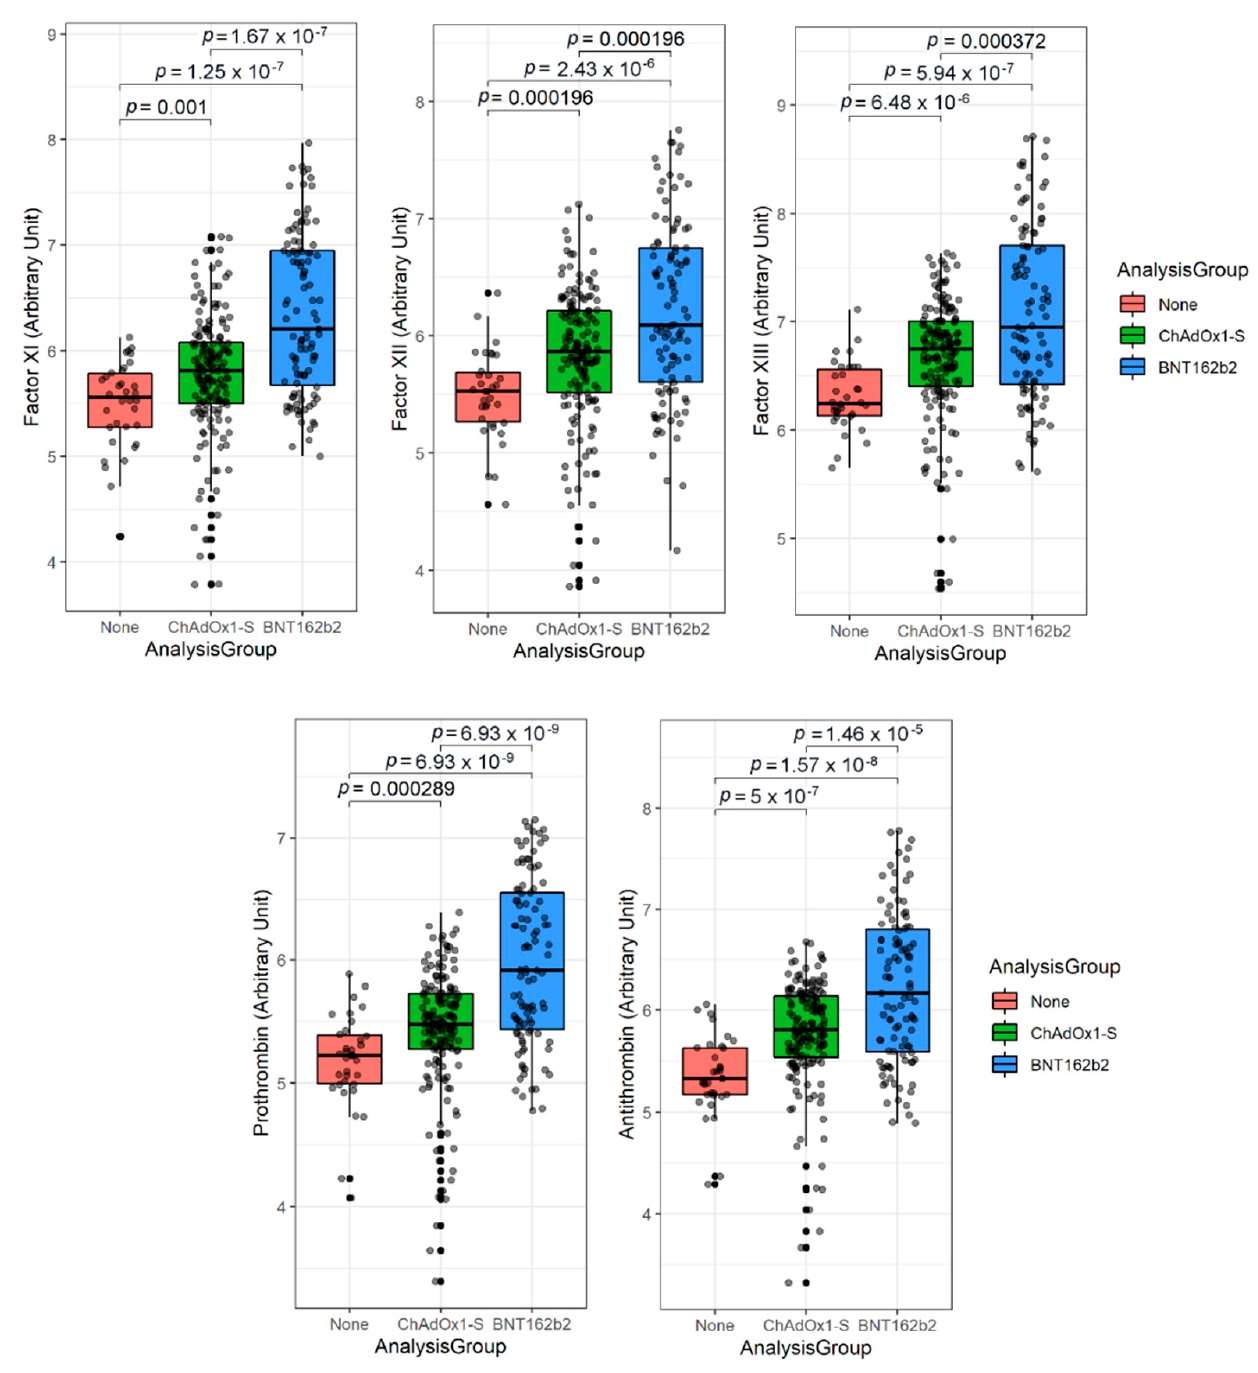
Figure 1. Circulating levels of coagulation factors and antithrombin after COVID-19 vaccinations. The figure shows the circulating levels of coagulation factors (XI, XII, XIII, and prothrombin) and antithrombin in the timeframe of two months since each group completed two doses of either the ChAdOx1-S (1–57 days post dose 2 with a median of 16 days (IQR: 8, 29); n = 166) or the BNT162b2 (1–44 days post dose 2 with a median of 27 days (IQR: 18, 36); n = 103) vaccine compared to a non-vaccinated group ( n = 34). Statistical analysis was conducted using R Core Team (2021) software. Values are log transformed to reduce skewness. Continuous values were compared using the Wilcoxon rank sum test.